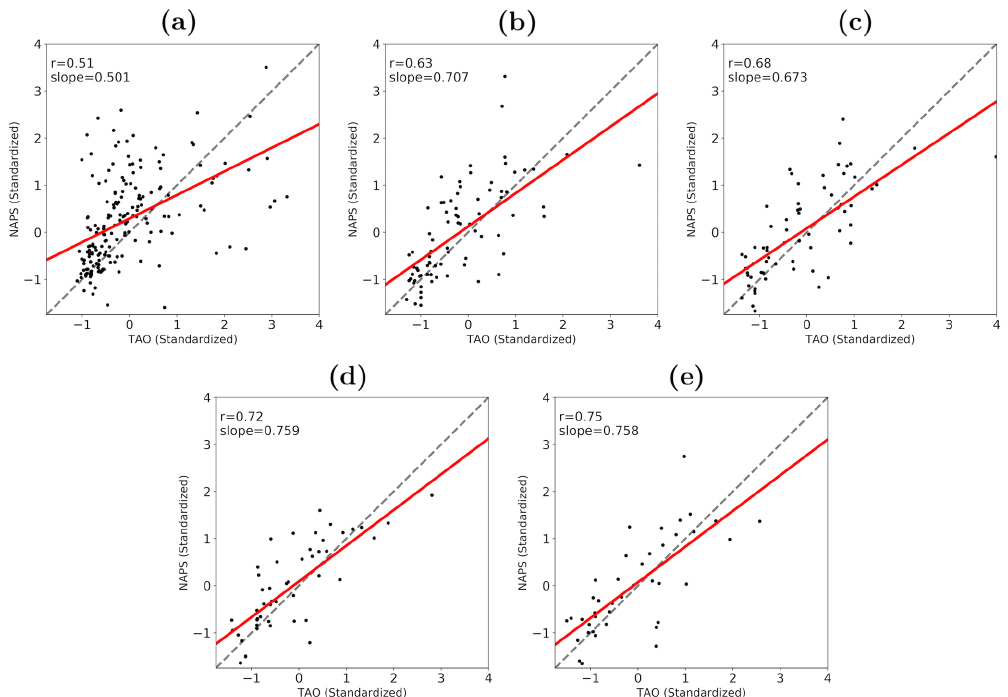
Figure 5. Standardized NAPS NH 3 surface VMR plotted against standardized FTIR NH 3 total column. (a) The raw comparison, where the closest daily average FTIR measurement is plotted for each NAPS observation if there are any within 72h. FTIR and in situ resampled to (b) 15d, (c) 18d, (d) 24d, and (e) monthly averages. The dashed lines indicate slope = 1, and the red lines indicate the fit to the data.